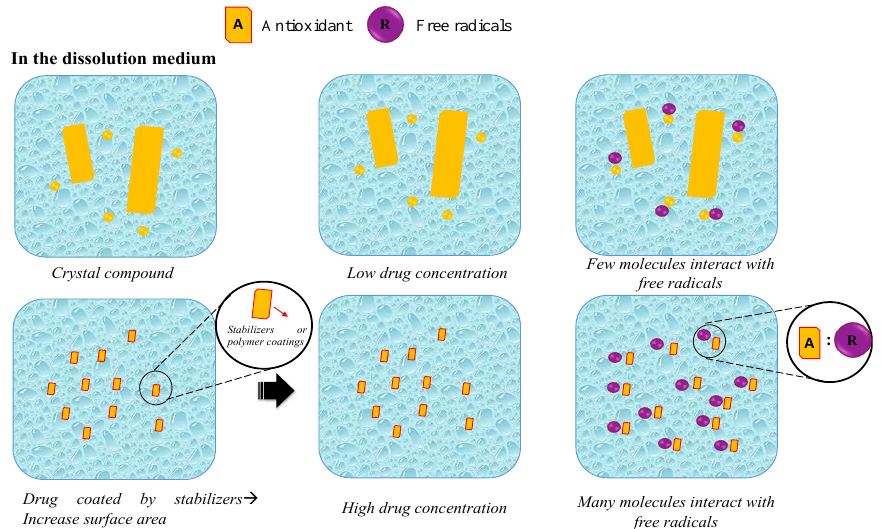
Figure 11. The schematic illustration of the antioxidant activity mechanism of the drug in nanoparticle drug delivery system and particle size reduction.